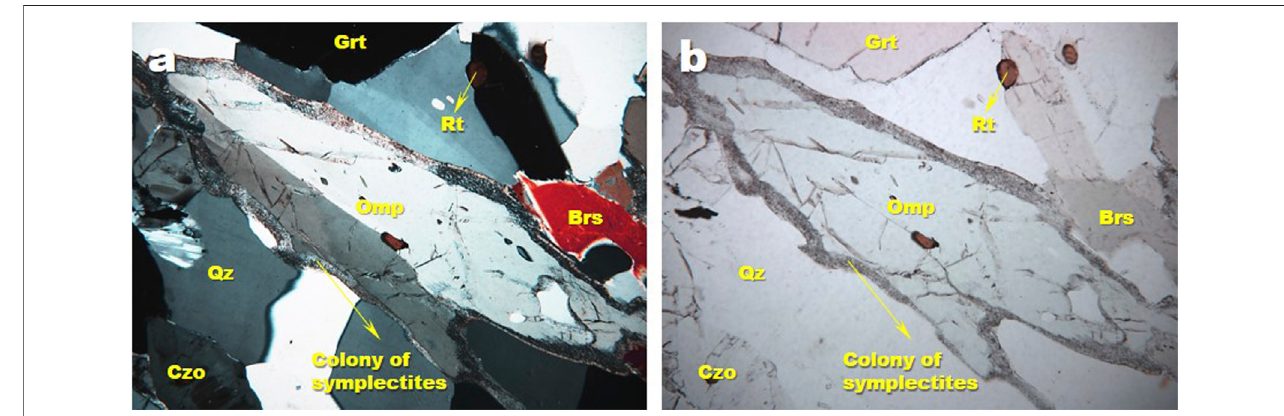
FIGURE 2 | Photomicrographs of the omphacite specimen observed under a transmitted light microscope with (A) cross polarized light and (B) plane light. The presence of omphacite (Omp), garnet (Grt), barroisite (Brs), clinozoisite (Czo), quartz (Qz) and rutile (Rt) is indicated.